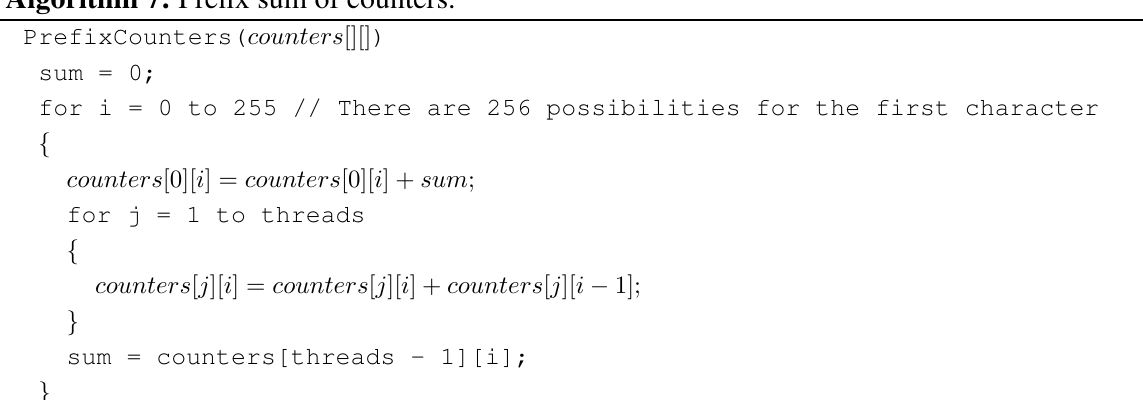
Algorithm 7: Prefix sum of